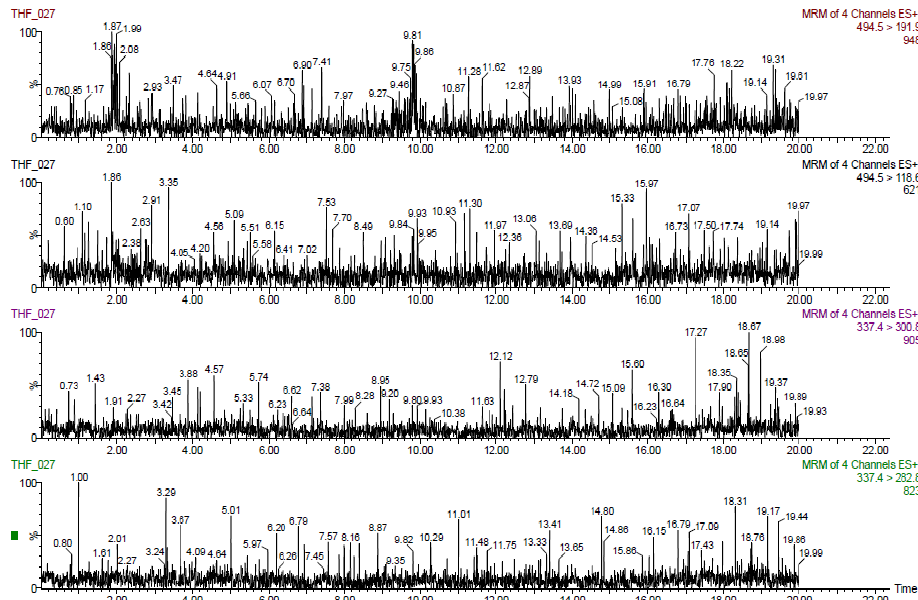
Figure A3. C hromatogram of a blank liver sample. Figure A3. Chromatogram of a blank liver sample.